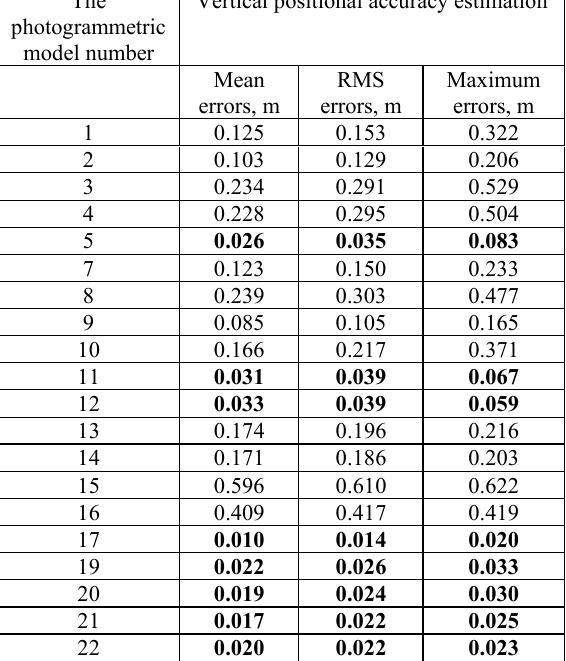
Table 5. Vertical positional accuracy estimation of generated photogrammetric models using check points located at 8 m away from the rail rack axis «a»